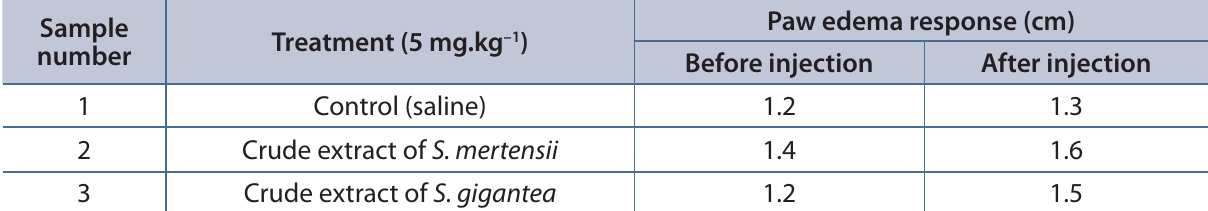
Table 3. Anti-inflammatory formation effect of S. mertensii and S. gigantea extract on at 2 mg.kg -1 of 20 ± 2 g male albino mice